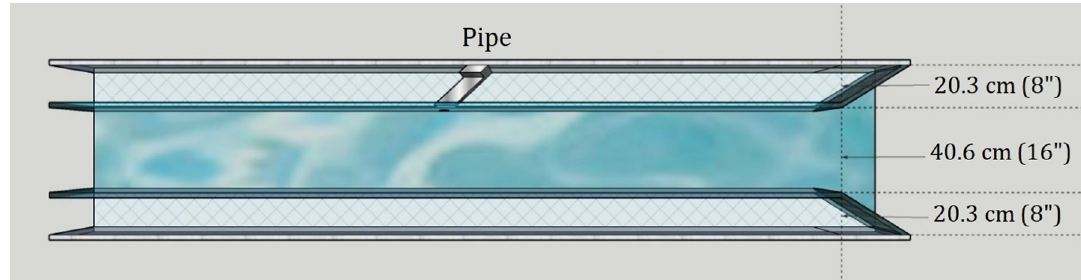
Figure 5. Narrow channel configuration (top view).